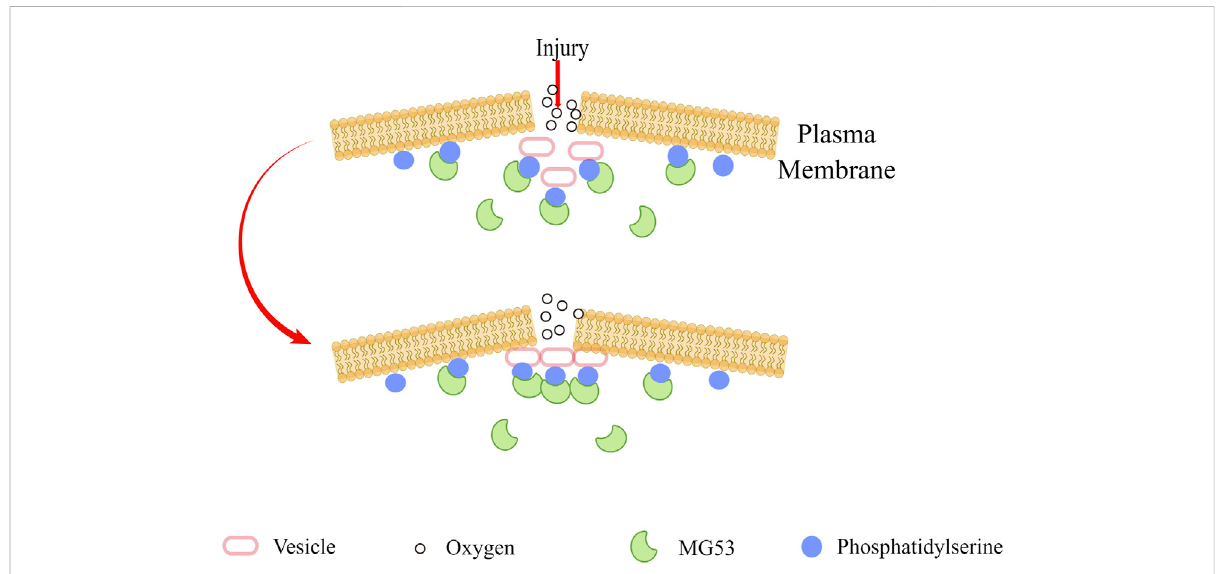
FIGURE 1 Whentheplasmamembranewasdamaged,MG53sensedtheoxidizedextracellularenvironment,andbycombiningwithphosphatidylserine,it adhered to the plasma membrane and intracellular vesicles, and fi nally gathered at the injury site to seal the damaged